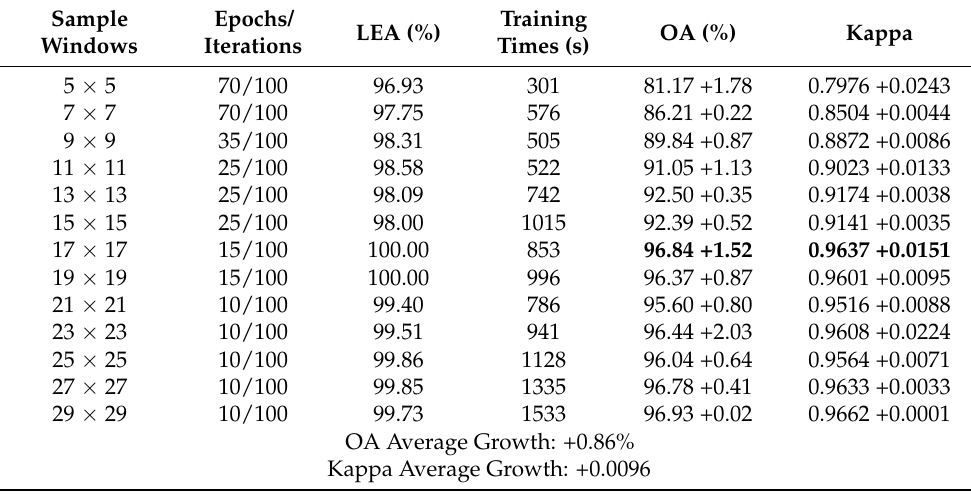
Table 6. Classification accuracy of Spatial